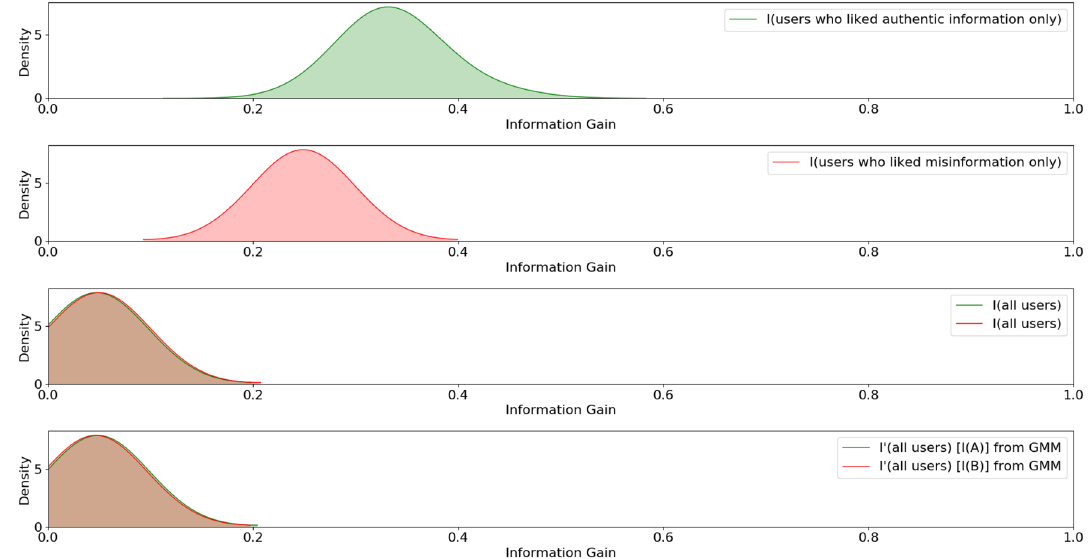
Figure 6. ( a ) Gaussian KDE of in-degree users who have only liked authentic media, ( b ) Gaussian KDE of in-degree users who have only liked fake media, ( c ) Gaussian KDE of all in-degree users who have liked authentic and fake media, ( d ) GMM approximation of information gain from authentic and fake